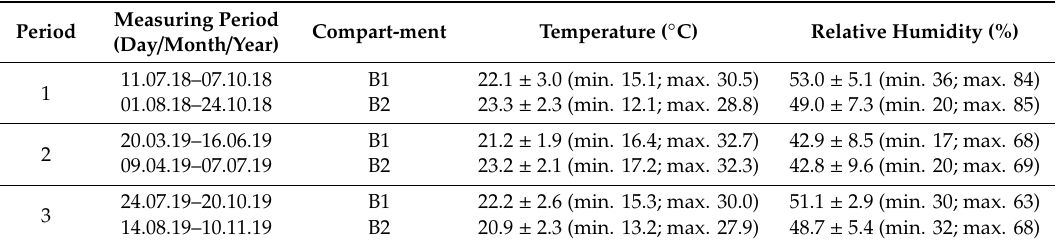
Table 2. Average temperature and relative humidity ( ± standard deviation) for each fattening compartment and period (records taken every